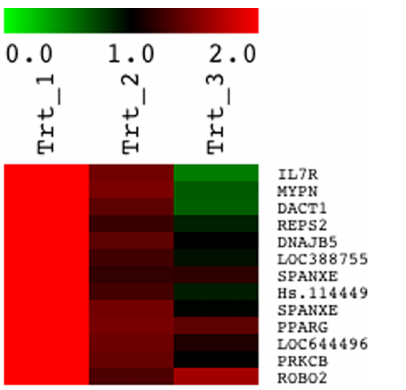
Figure 7. A subset of TR b 1 target genes that are inhibited by SIRT1 knockdown. Heat map representing results of array analysis performed on HepG2-TR b 1 cells treated + / 2 T 3 and SIRT1 siRNA and displaying probe sets in which T 3 response is inhibited by SIRT1 siRNA. Scale is shown at top. The first lane (1) represents T 3 responses obtained in the presence of control siRNA, second lane (2) represents T 3 responses obtained in the presence of SIRT1 siRNA. The third lane (3) represents comparison of mRNA expression levels in the presence of control siRNA or SIRT1 siRNA. Note that, in most instances in which SIRT1 inhibits these T 3 responses, this effect is not accompanied by SIRT1-dependent changes in basal gene expression.